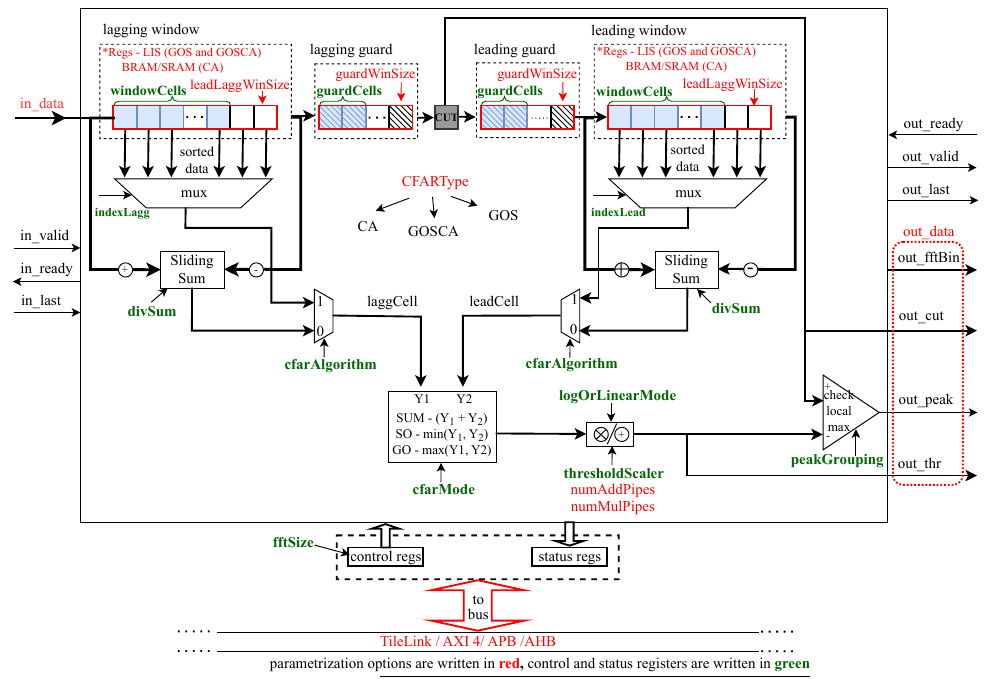
Figure 11. Block diagram of the CFAR design generator showing input and output signals as well as the versatile internal organization with plentiful available design parameters and control registers. Control registers are shown in green; parametrized options are written in